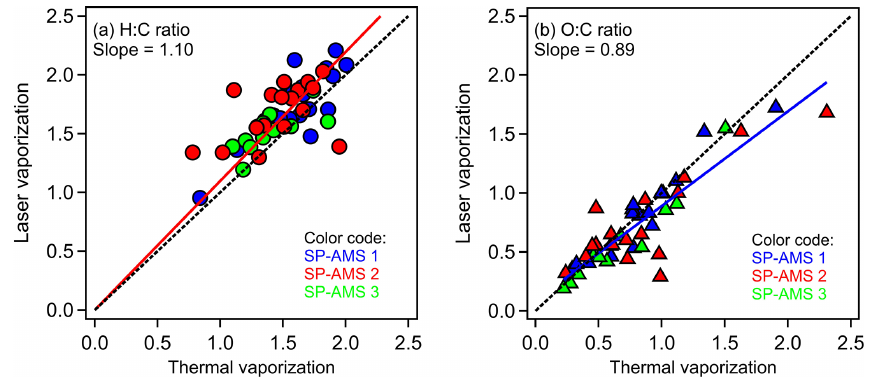
Figure 5. Comparisons of H : C and O : C ratios of oxygenated organic compounds determined using the LV and TV schemes. The I-A method was used for the elemental analysis. The dashed and solid lines represent 1 : 1 line and data fitting,